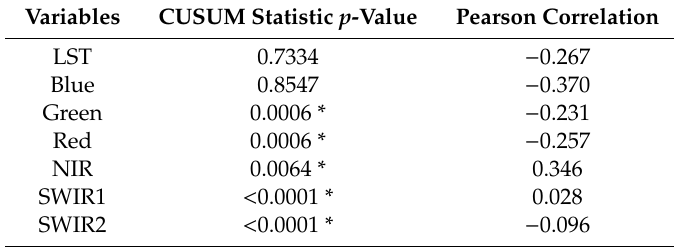
Table 3. CUSUM statistic and Correlation (Pearson) among the wavelength reflectance, land. Surface temperature and soil moisture content from total measured